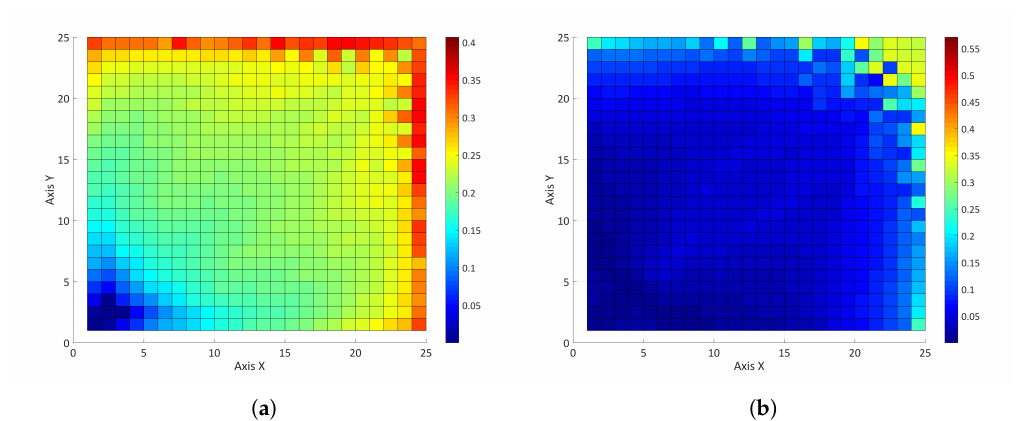
Figure 21. Oil saturation at the end of the EOR process under two different configurations of salt (initial/injected): 1.5/0.5% ( a ) and 1.5/1.5% ( b ).